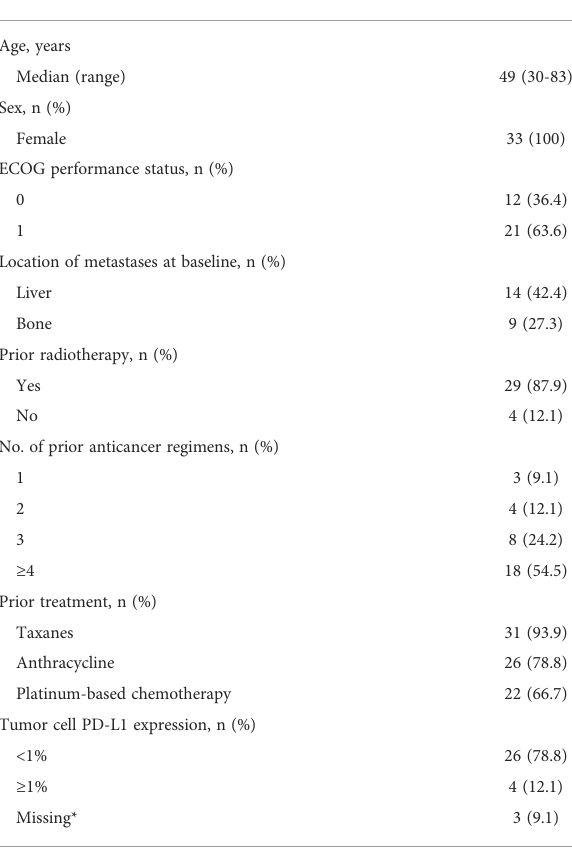
TABLE 1 Baseline patient and disease